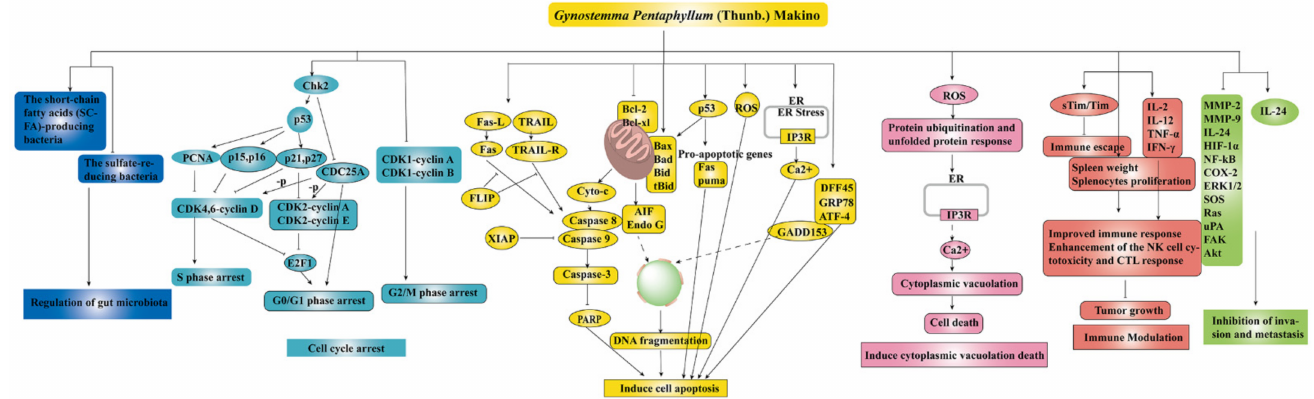
Figure 4. The anti-cancer mechanisms of GP ↑ meant up-regulation, ⊥ meant